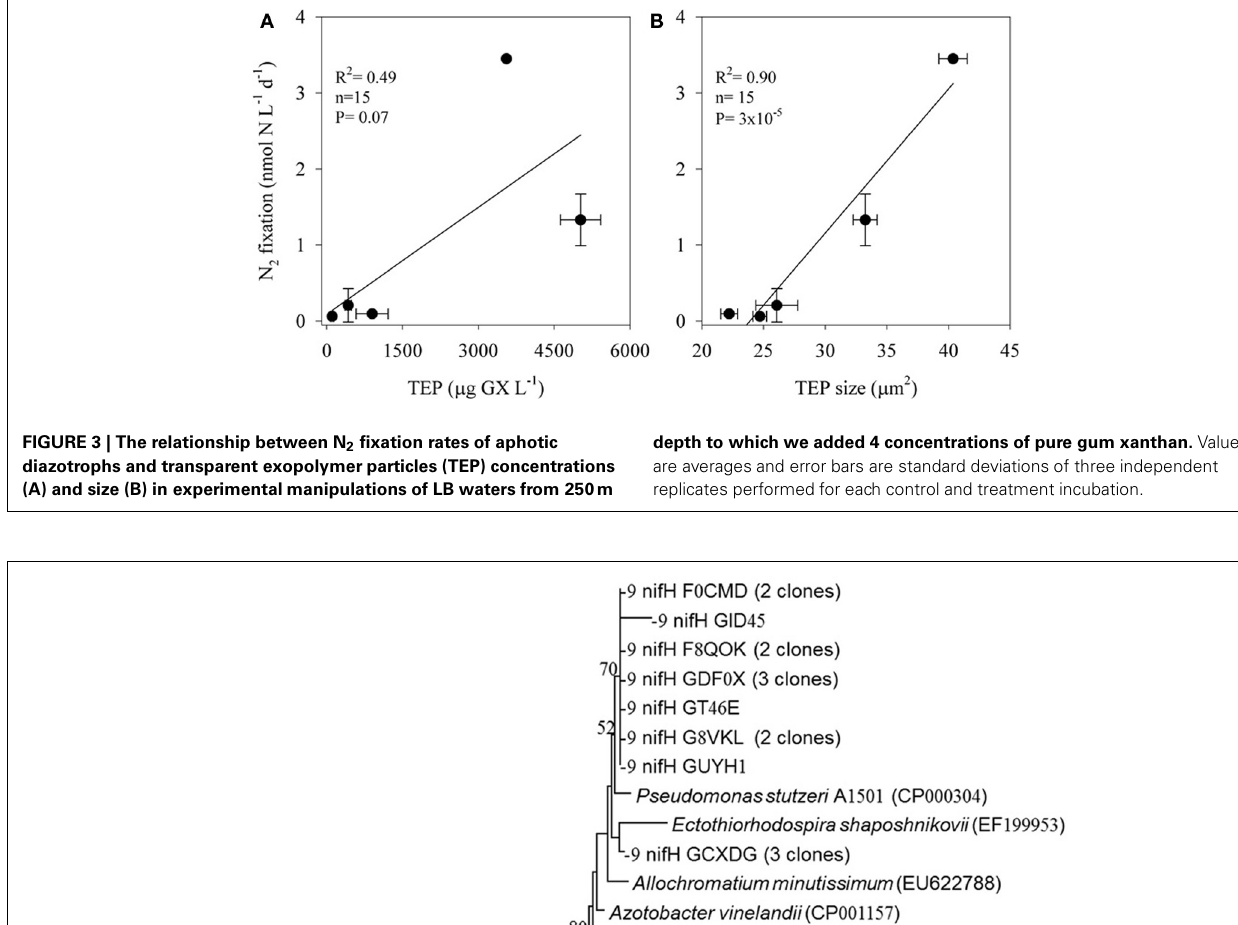
FIGURE 4 | nifH gene tree of clones retrieved from the aphotic layer in the Levantine Basin. Numbers in parentheses represent the number of clones in the library that were identical to the clones in the phylogenetic tree. Bootstrap values above 50% are indicated above the nodes.